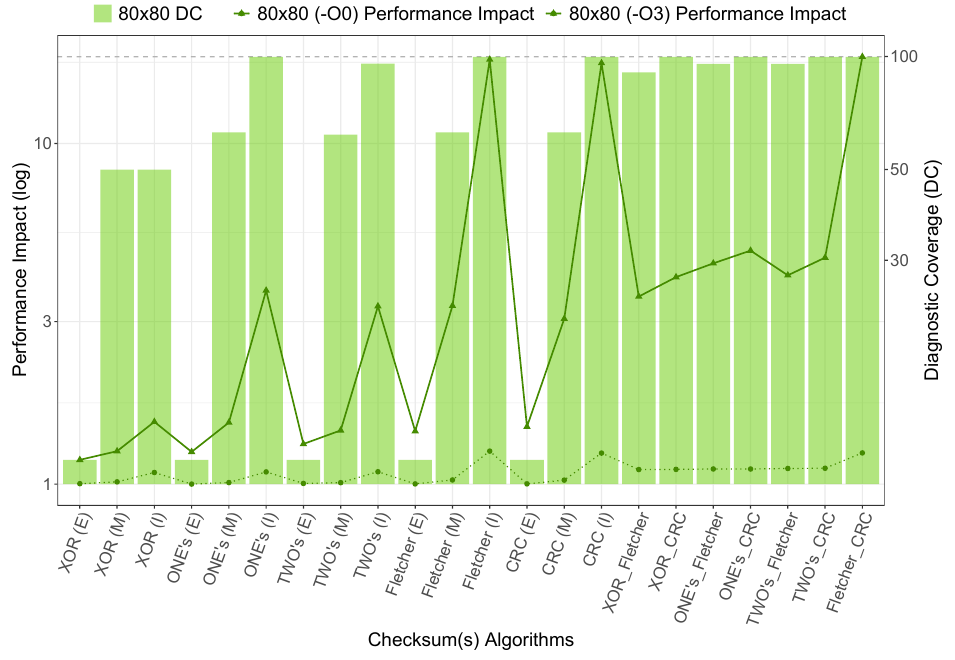
Figure 7. Trade-off between performance impact vs. DC.